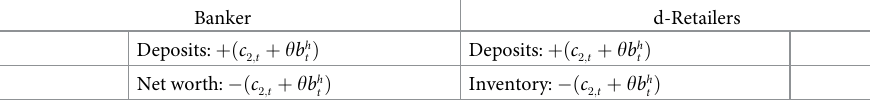
Table 6. Banker buys goods from d-retailers.